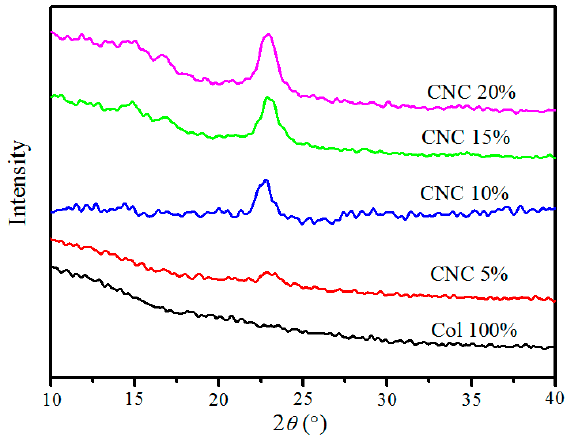
Figure 6. XRD curves of CNC/Col hydrogels.